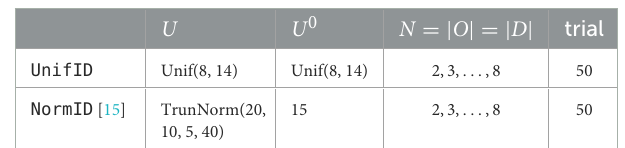
TABLE 2 Summary of two datasets, UnifID and NormID